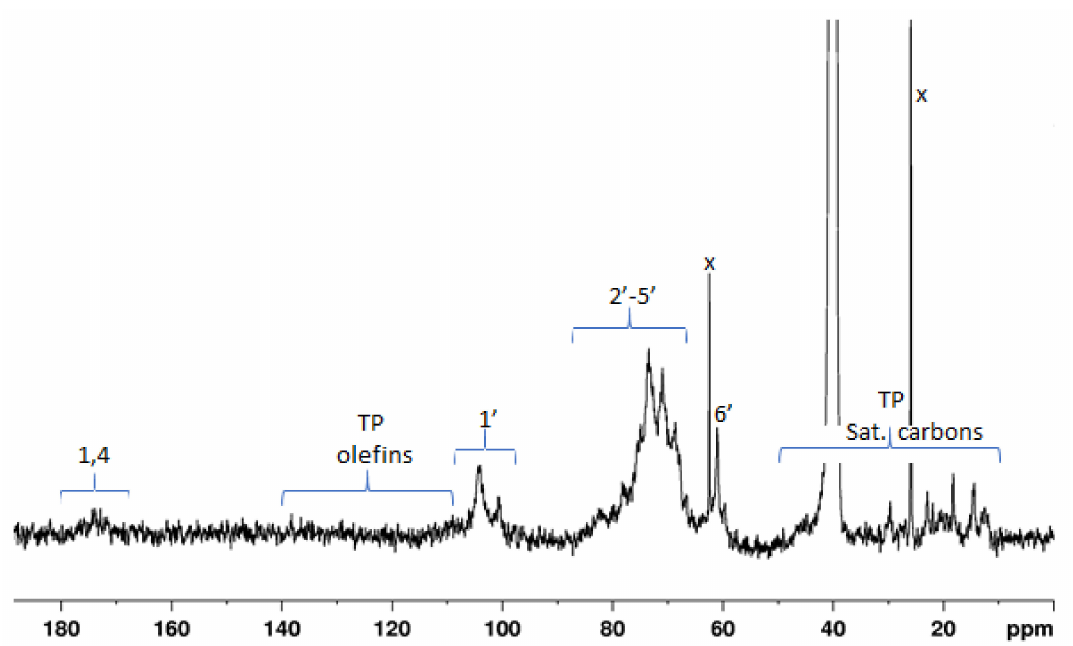
Figure 4. 13 C NMR spectrum of a CG–TPSA adduct in d 6 -DMSO. The carbon numbers follow Scheme 1; D = DMSO; R = methyl from rhamnose, x = isopropanol, TP = tetrapropene